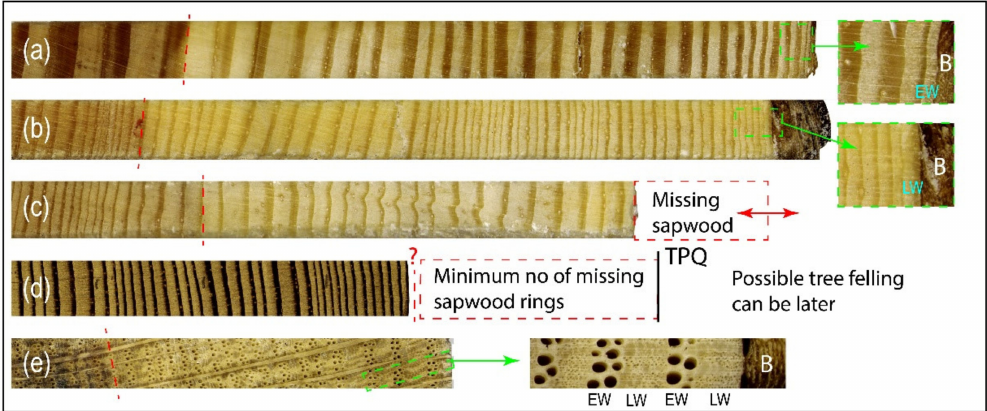
Figure 4. ( a ) Pine wood sampled 10 June 2019 in South Sweden. The 2019-year ring is not complete and the waney edge and some bark (B) is preserved. A dendrochronological dating of the sample would therefore be as precise as summer 2019. ( b ) Pine wood sampled in August 2019 in central Sweden. The 2019 growth ring contains both earlywood (EW) and latewood (LW) under the bark (B). A dendrochronological dating of the sample would therefore be the dormant (autumn/winter) season between autumn 2019 and spring 2020. ( c ) A pine sample with sapwood, but no bark or waney edge preserved. Missing sapwood rings must therefore be considered in dating, which means that the dating has a margin of error. ( d ) A pine sample without sapwood. A terminus post quem (TPQ) date is therefore the only correct option. In this case, the outermost ring is AD 1098. Based on the growth rate of the tree as well as number of sapwood rings from other matching samples from the same building, an estimated minimum of 55 sapwood rings were in this specific case added. The earliest possible tree felling can then be estimated to AD 1153. However, pine trees with more than 100 sapwood rings have been observed. Moreover, we do not have any information about the number of missing heartwood rings. The felling year can therefore be decades, perhaps even centuries after the terminus post quem dating. ( e ) Example showing heartwood and sapwood of an oak sample with close up on the outermost rings to show earlywood and latewood. The dashed red lines show the boundaries between heartwood and